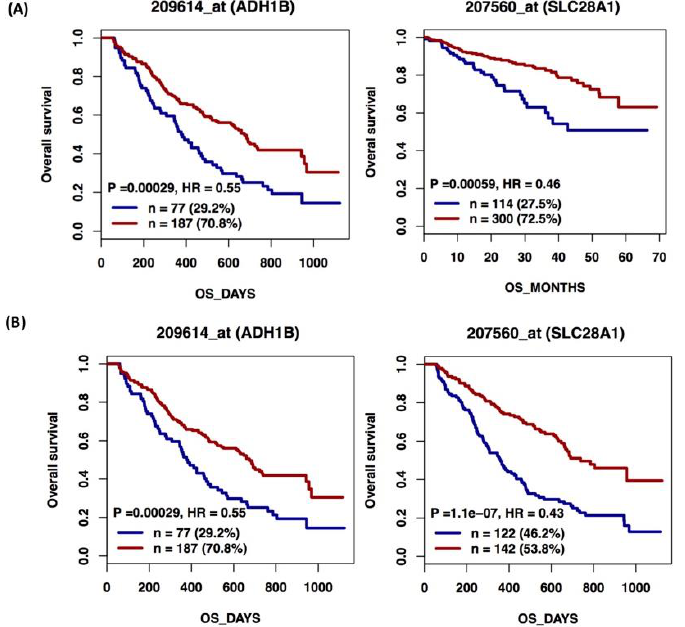
Figure 1. Overall survival (OS) by gene expression level. The survival analysis of 414 MM patients from the Arkansas cohort in GSE4581 ( A ) and 264 MM patients in GSE9782 ( B ) from Mulligan et al., classified according to gene expression levels: high (red) or low (blue). We used days’s scale to plot OS. P: p -value; HR: Hazard Ratio; n: number of patients.